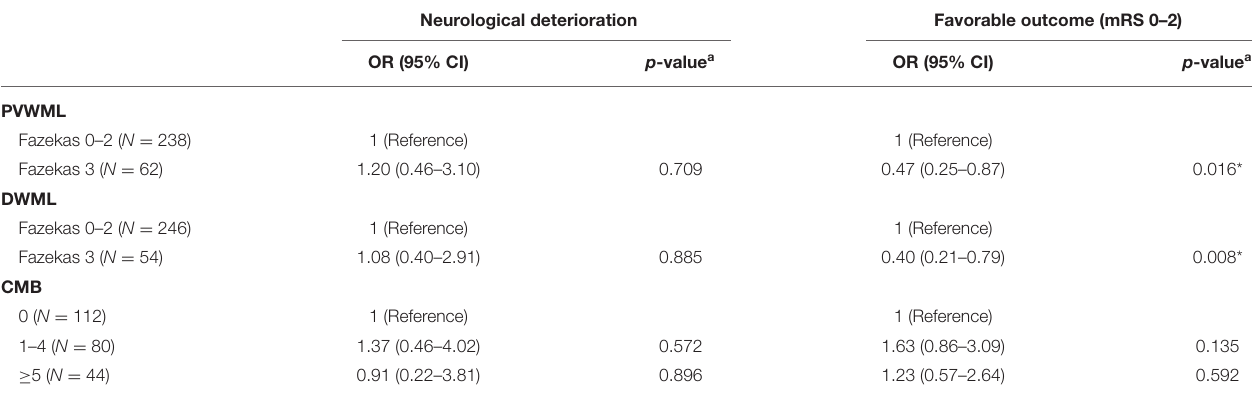
TABLE 6 | A multivariable logistic regression analysis to estimate the odds ratio (OR) of burdens of white matter lesions and cerebral microbleeds for neurological deterioration and favorable outcome in stroke patients with aspirin treatment failure. Neurological